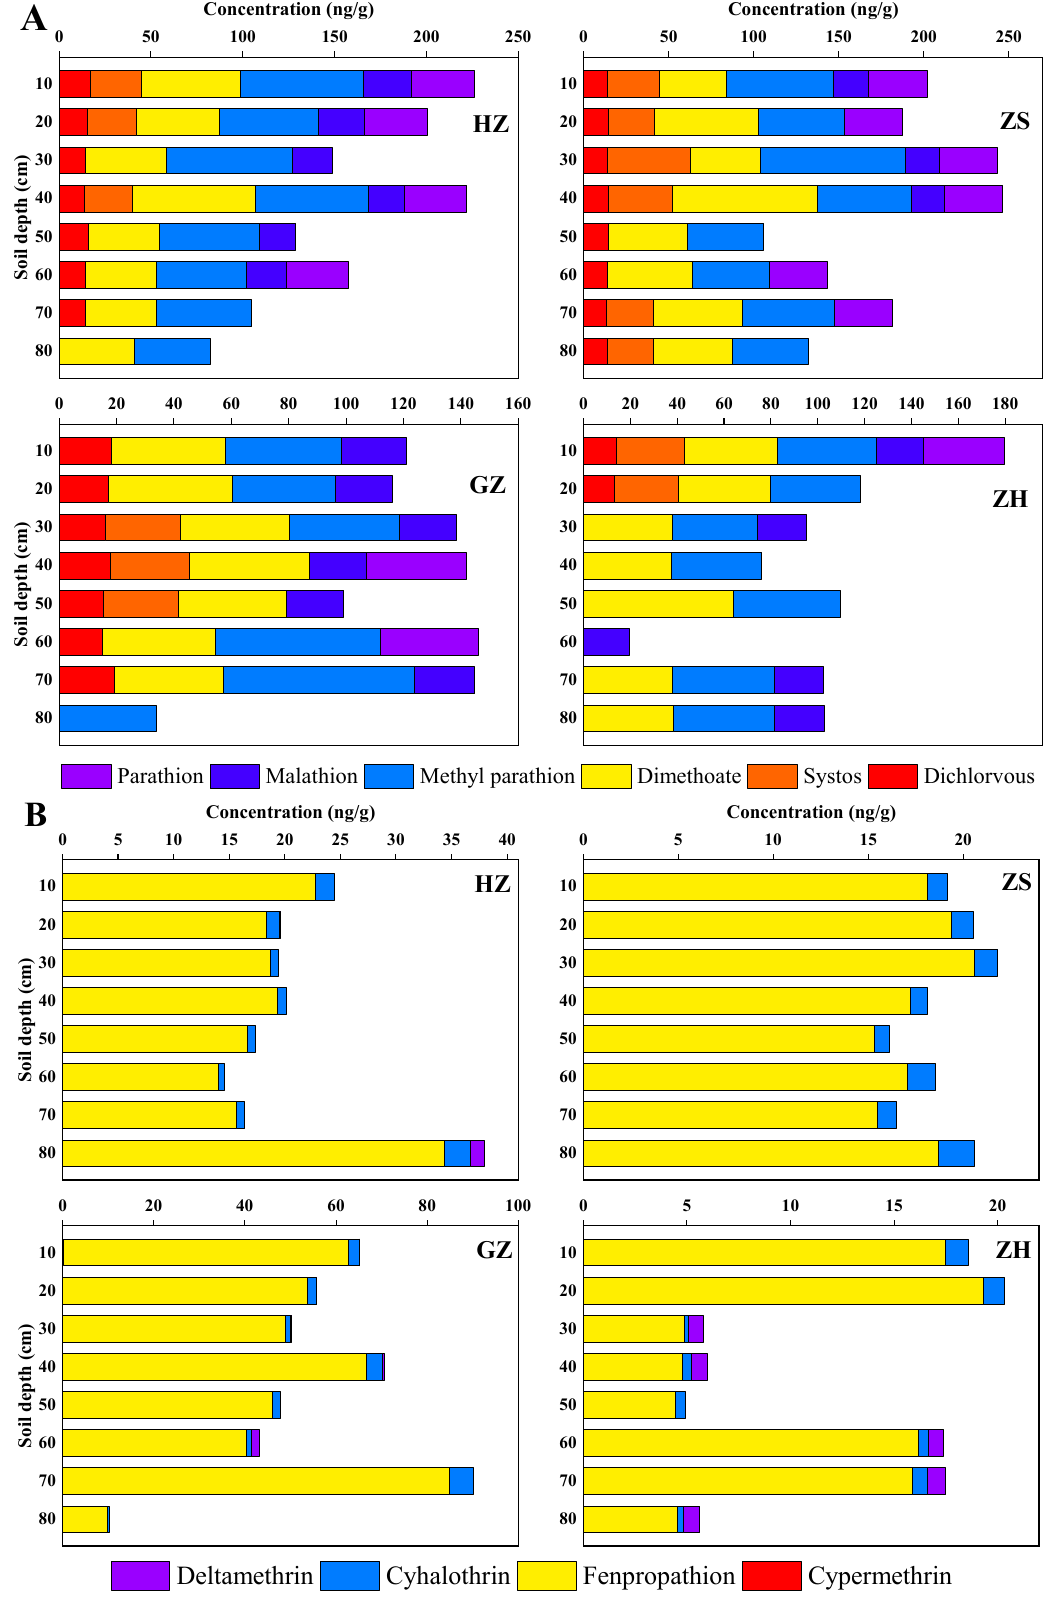
Figure 4. Vertical distributions of the concentrations and compositions of OPPs ( A ) and PYs ( B ) in agricultural soils of the PRD region.